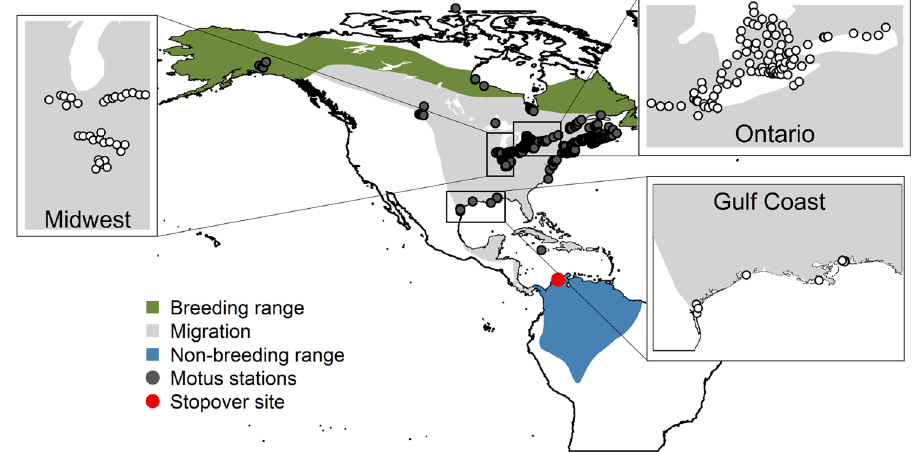
Figure 1. Known distribution map of the Grey-cheeked Thrush 36 , highlighting the spring stopover site in northern Colombia. The three zoomed panels show the regions with most of the detections of migrating Grey- cheeked Thrush in North America, following their departure from Colombia. Dots represent the automated receiving stations that were operational during 2015 and 2016. Map generated using BirdLife International and Handbook of the Birds of the World (2016) Bird species distribution maps of the world. Version 6.0. Available at